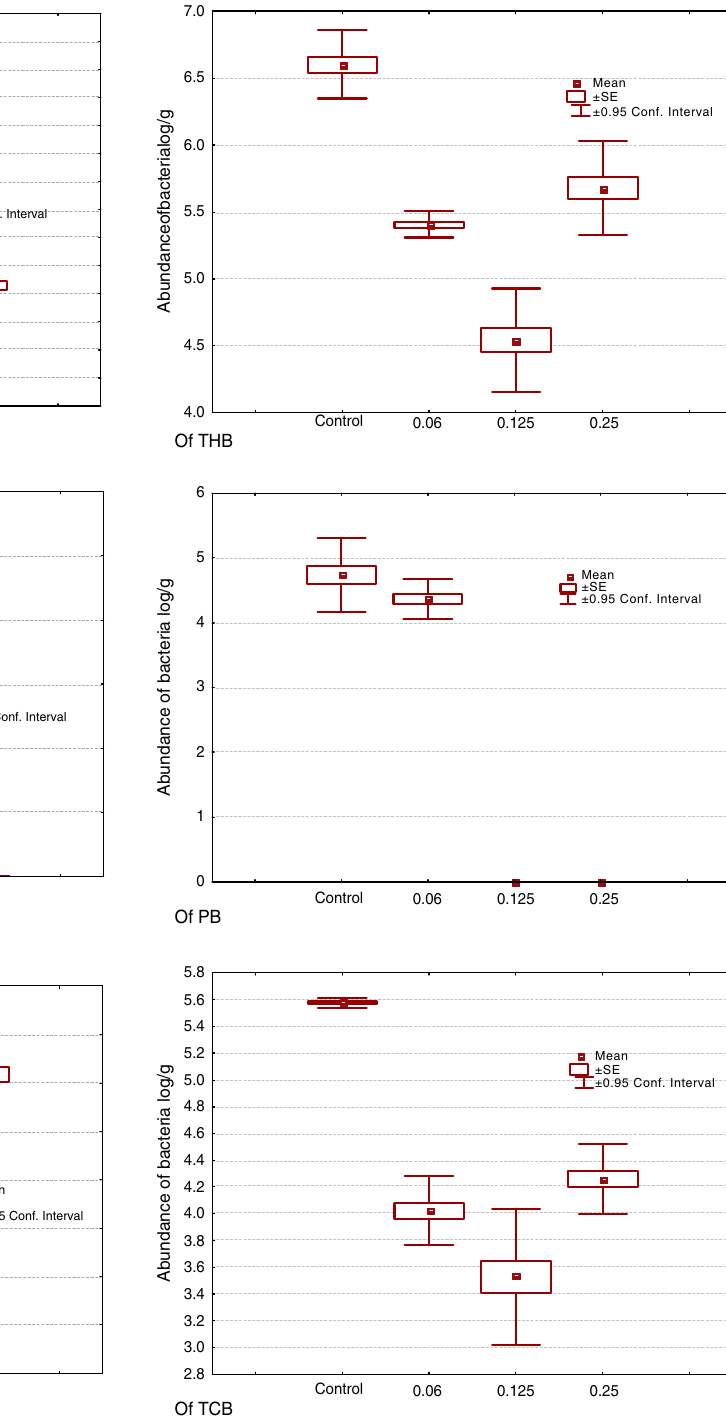
Fig. 2. The impact of the 96-hour exposure to the LC50 Cu (cid:2) Zn ions mixture on abundance of bacteria in digestive tract of trouts after 4 days keeping fish in clean water Concentration in parts of equitoxic 96-hour LC50